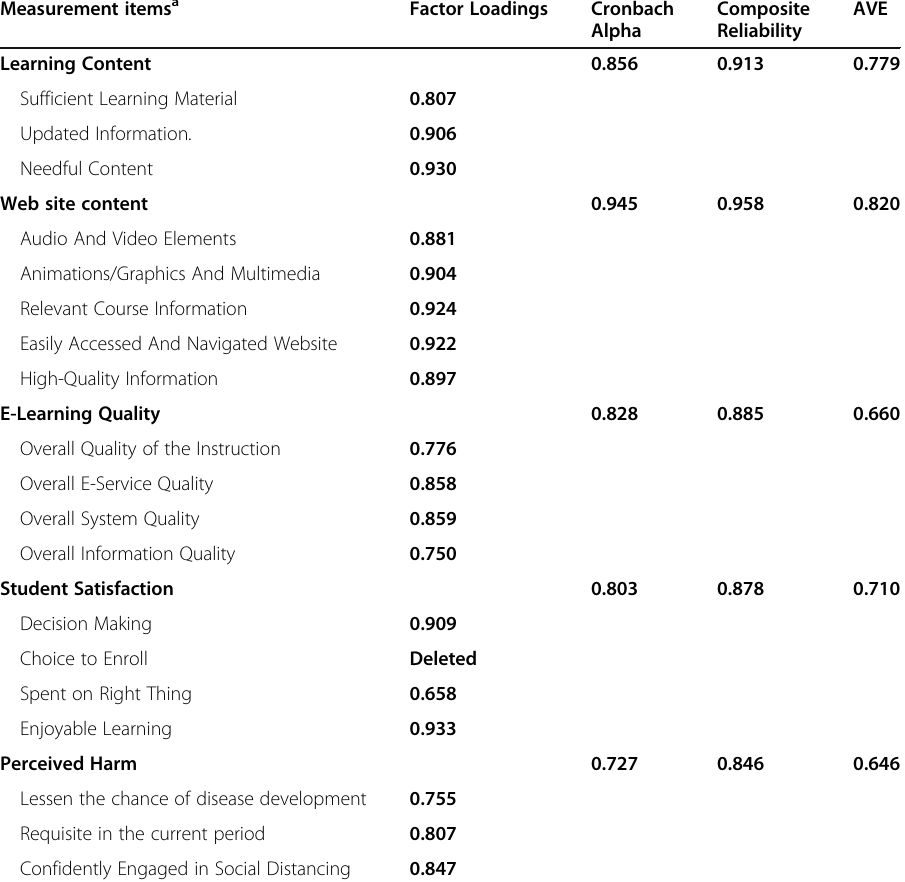
Table 2 Measurement model